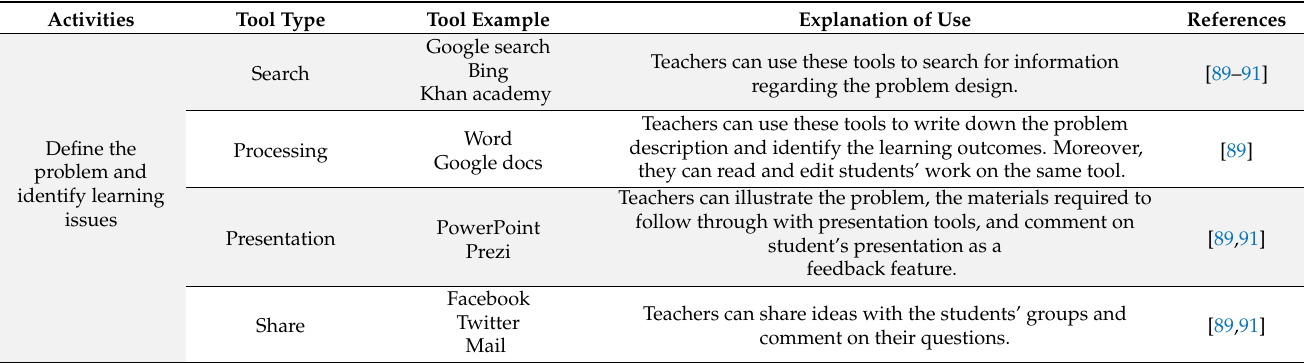
Table 4. PTE guide for problem-based